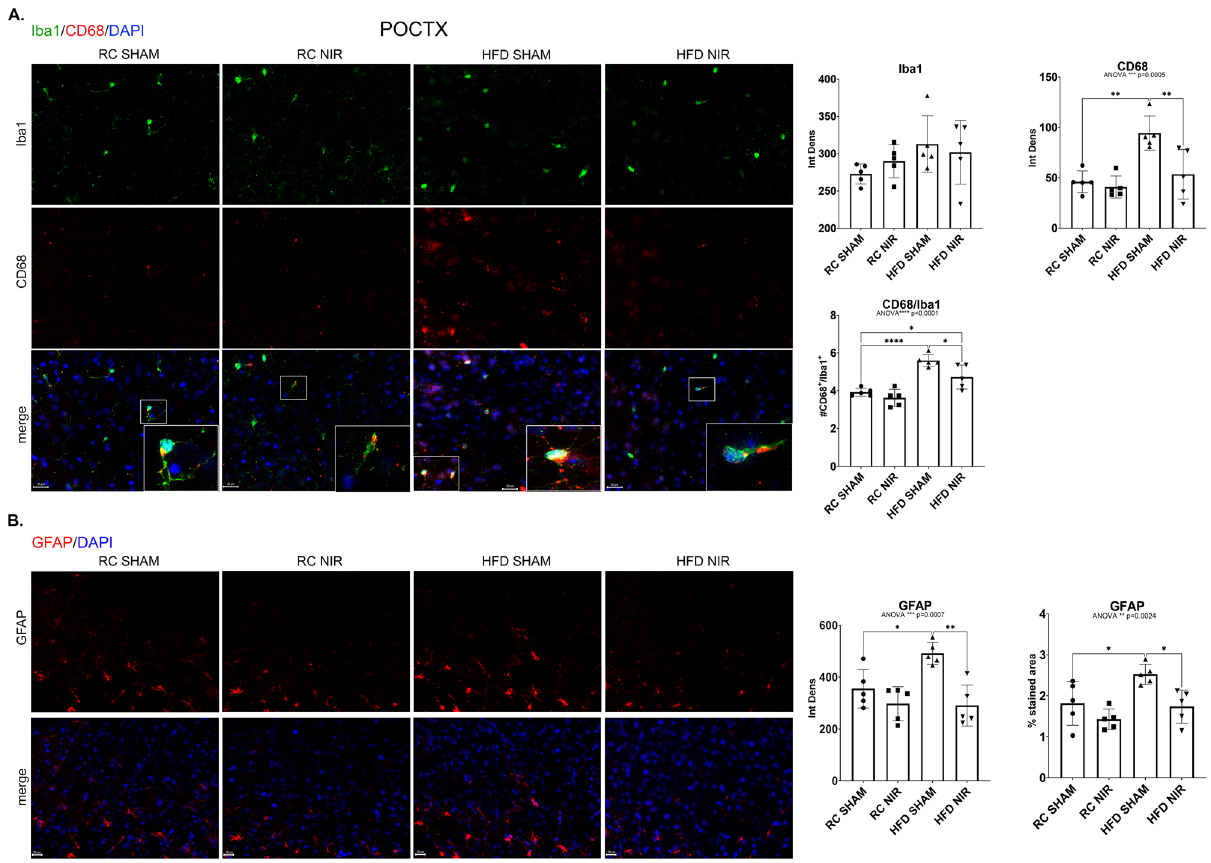
microglia activation (CD68) in HFD SHAM mice compared to control groups. NIR reduced CD68 in HF-fed mice. Magnification: 60X. ( B ) NIR reversed the HFD-induced increase in GFAP to levels close to control. Magnification: 40X. Image results of Z-stacks with pitch of 2.0 μm. n = 5 animals/group. Data are presented as mean ± SD. Each point is the average of 6 images/animal from 2 technical replicates. Statistical analyses: